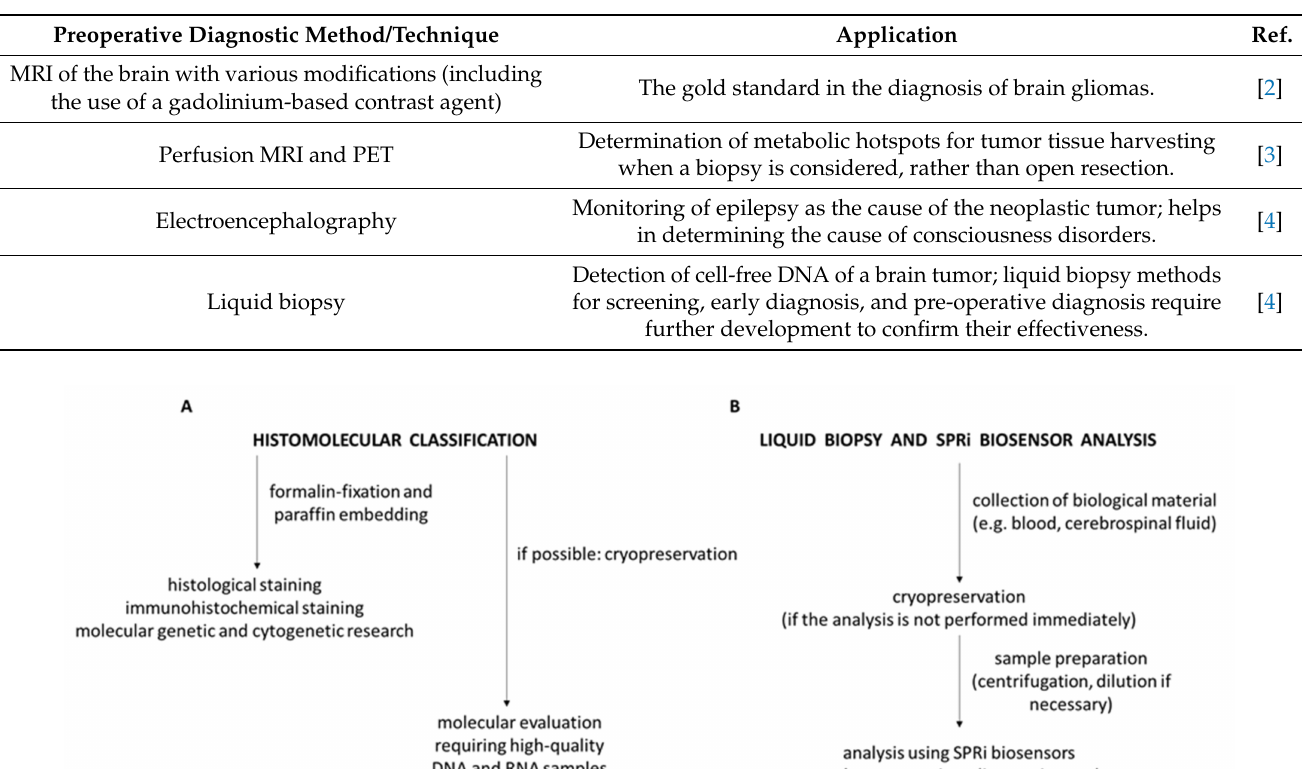
Table 1. Preoperative methods and diagnostic techniques used for the diagnosis of brain gliomas.